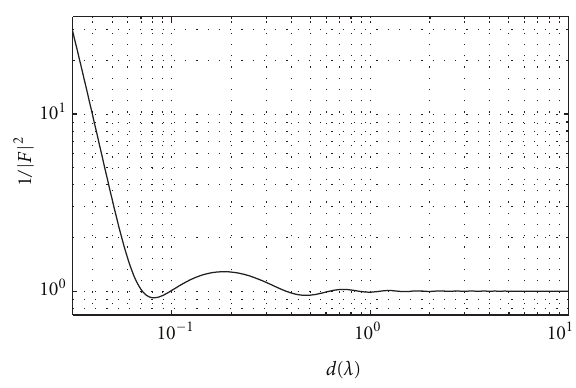
Figure 2: Plot of 1 / | F | 2 versus d for τ 1 = 1 = τ 2